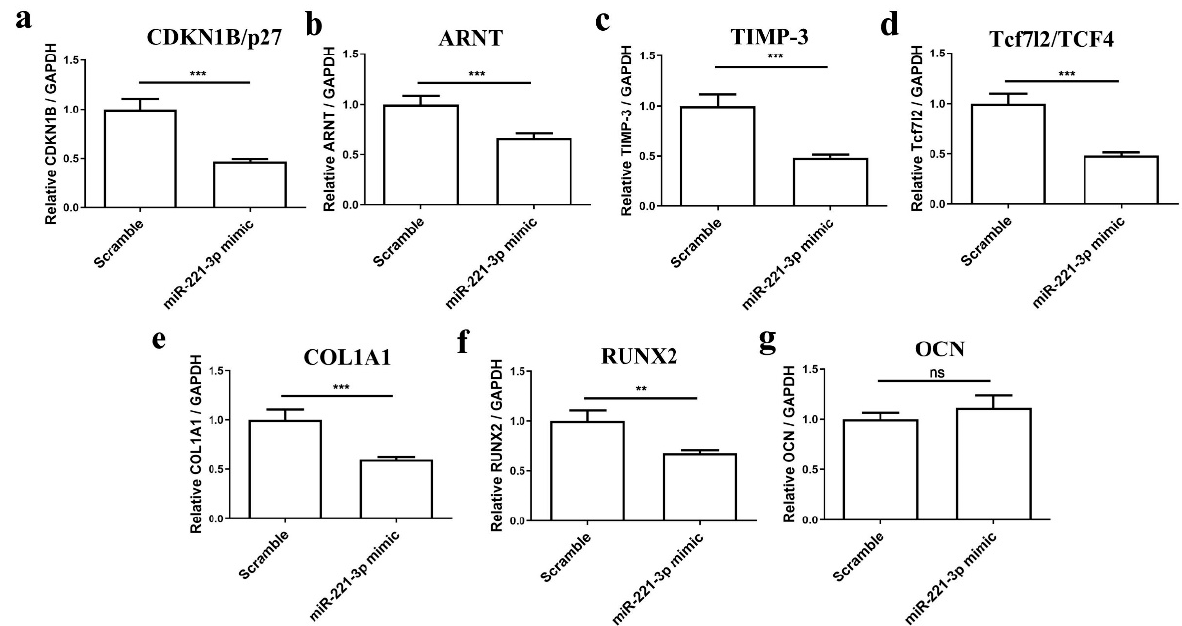
Figure 6. Secreted molecules from chondrocytes inhibited targets expression of miR-221-3p and osteogenic markers in osteoblasts. CDKN1B/p27 ( a ), ARNT ( b ), TIMP-3 ( c ), and Tcf7l2/TCF4 ( d ), and osteogenic markers ( e – g ), COL1A1, RUNX2, and OCN in osteoblasts cocultured with chondrocytes transfected with miR-221-3p mimic compared with scrambled control. Relative to GAPDH. ns stands for not statistically significant, ** p < 0.01, and *** p < 0.001 vs. corresponding control.